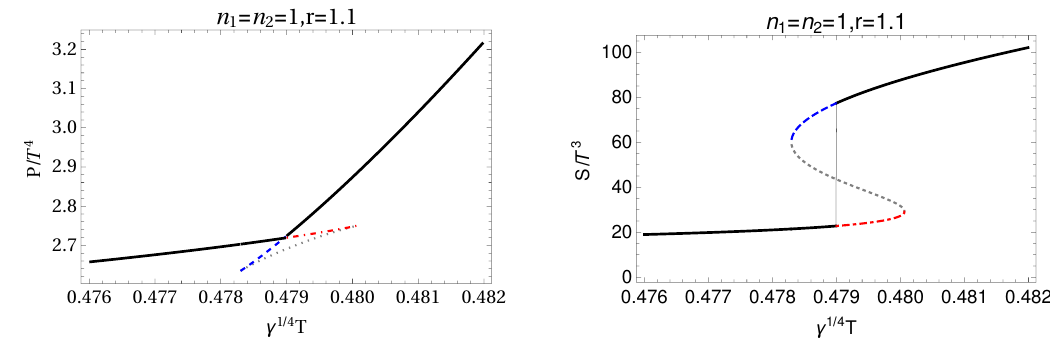
Figure 5 . Pressure (left panel) and entropy (right panel) around the (cid:12)rst-order phase transition with n 1 = n 2 = 1 and r = 1 : 1. The pressure of the ground state is given by the maximal value at each temperature. At the critical temperature the slope changes discontinuously. The lines which extend smoothly beyond this point when coming from lower or higher temperatures correspond to superheating or supercooling phases, respectively. (The lower line connecting the endpoints of supercooling and superheating corresponds to the entropy curve with negative slope and thus cannot be accessed physically.) The dotted line in the entropy curve indicates the jump in the entropy that occurs when there is no supercooling or superheating.